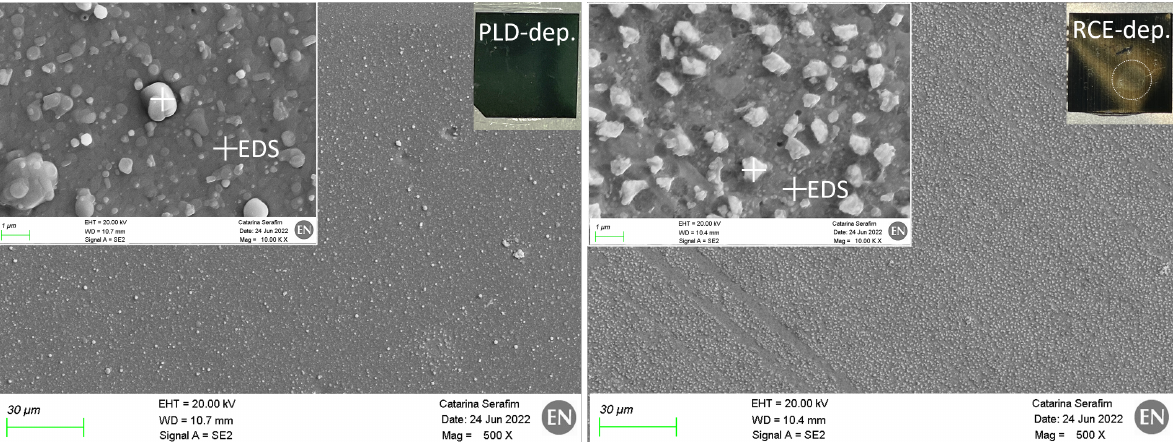
Figure 2. SEM images of REBCO samples with the well–visible nanocrystal–covered surface. Crosses represent the EDS measurement positions. Left : PLD–deposited, a wide range of crystal sizes. Right : RCE–deposited coating, uniformly sized crystals. Details in the text. The SEM images were taken on FE–SEM Zeiss